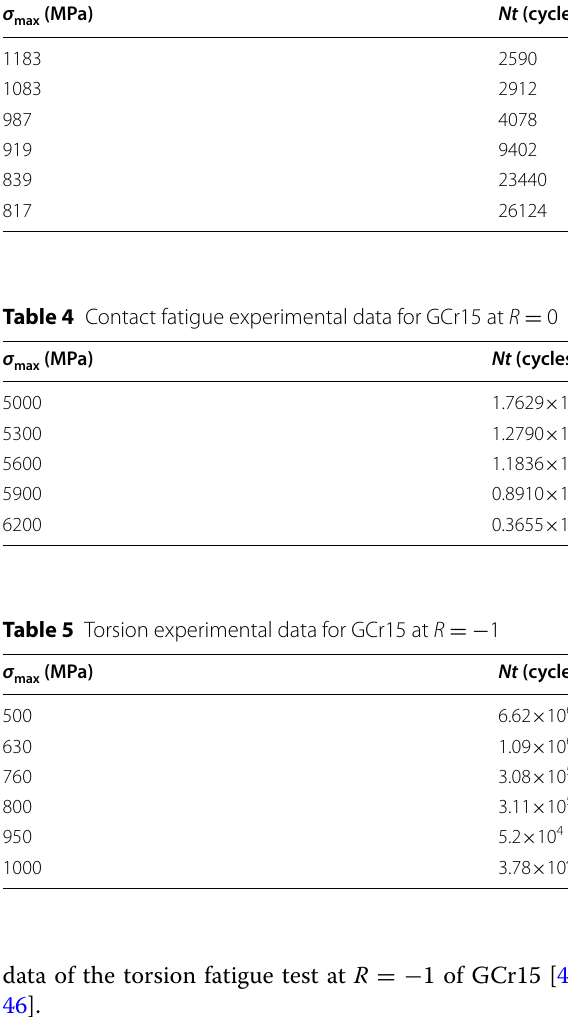
line indicates the more accurate result.